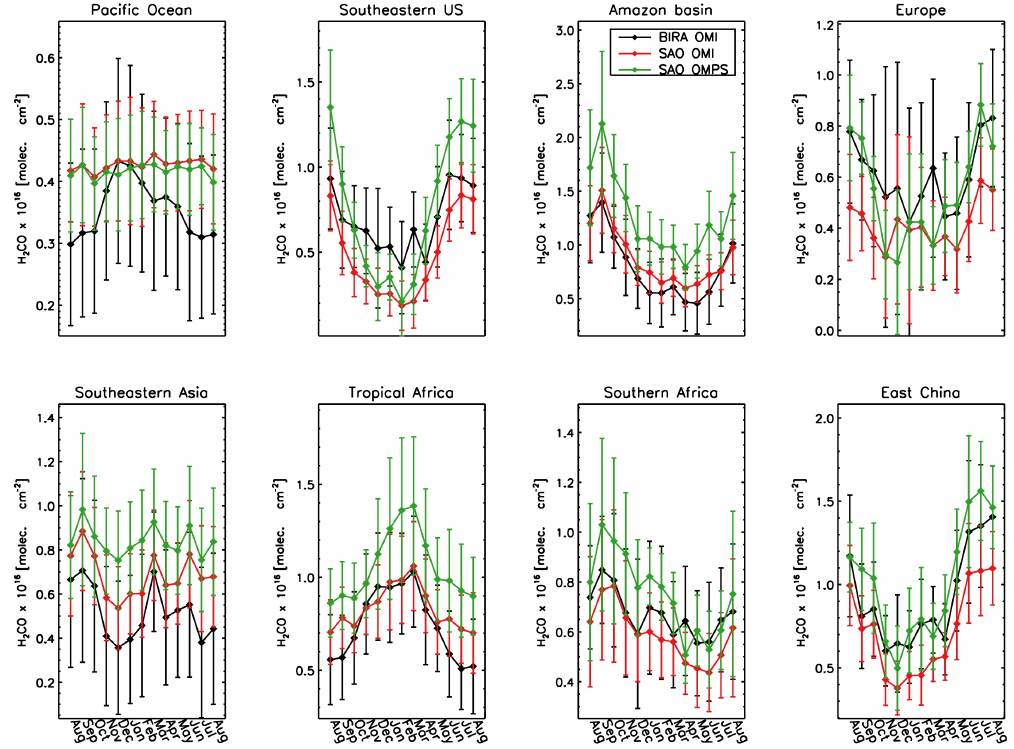
Figure 8. Monthly means between August 2012 and August 2013 for the eight regions depicted in Fig. 6. Error bars represent the standard deviation of the mean value with in the region. Green lines and data points represent OMPS SAO retrievals, red is used for OMI SAO, and black for OMI BIRA. The shapes of seasonal cycles are reproduced similarly by the three retrievals despite having significant offsets, which are further analyzed in Fig.